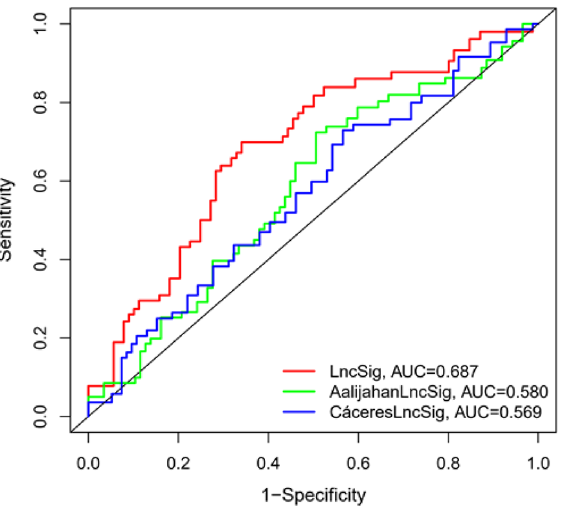
Figure 7. Combined survival analysis of model comparison. The ROC analysis at 3 years of overall survival for the LncSig, AalijahanLncSig and